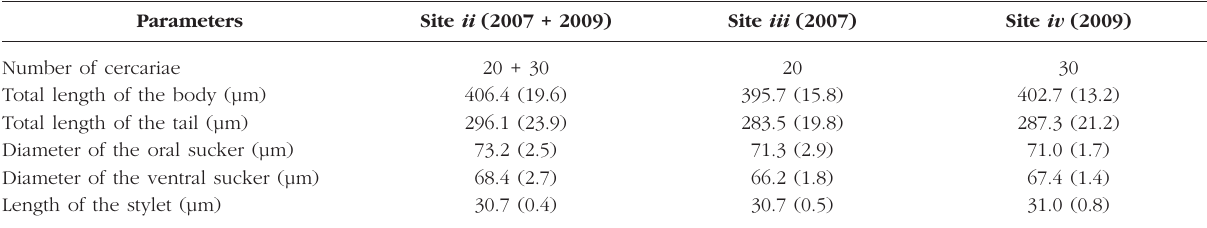
Table III. – Mean values (S.D.) of five parameters measured on some heat-killed cercariae of H. cylindracea after their shedding from snails originating from three